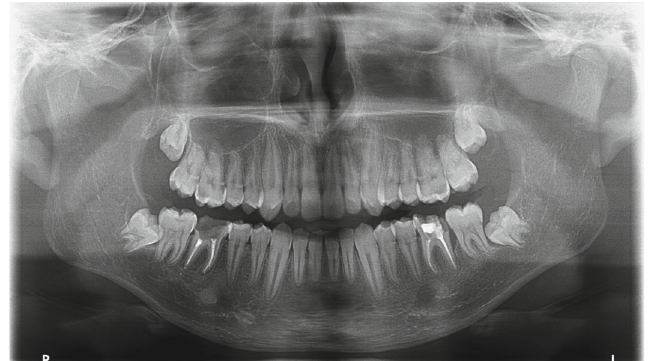
Figure 1: Initial panoramic